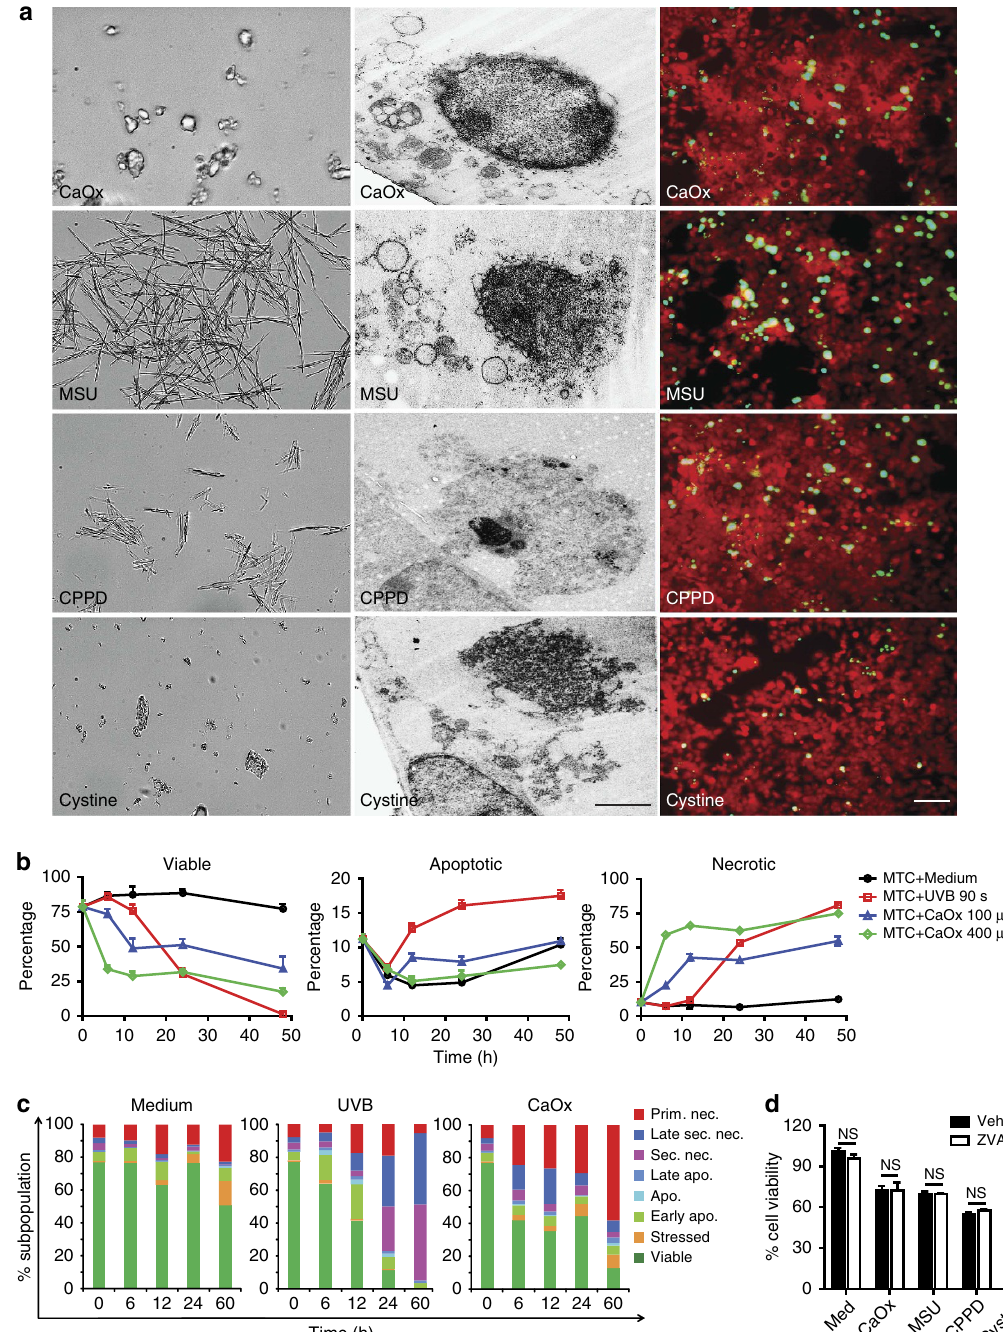
Figure 1 | Crystals induce primary cell necrosis. ( a ): Various crystals were incubated with tubular epithelial cells as indicated. Images show the crystal shapes at a magnification of (cid:2) 1,000 (left), TEM images shows that these crystals induce necrosis of tubular epithelial cells as indicated by ruptured plasma membranes (middle, (cid:2) 2,000), scale bar, 2 m m. The images on the right show the same rhodamine-labelled monolayers (red) 24h later. When Sytox green is added to the medium cells with permeable plasma membranes turn green indicating cell death ( (cid:2) 200), scale bar, 40 m m. ( b ) Flow cytometry was used to define the type and stage of tubular cell (MTC) death on CaOx crystal exposure or ultraviolet light type B for 90s (s) over a period of 50h as described in methods. Data for viable cells, apoptotic cells and necrotic cells are expressed as the percentage of viable cells ± s.e.m. of all cells for each time point. ( c ): The graphs show a quantitative analysis of the same experiment displaying all different phenotypes of tubular epithelial cells. Flow cytometry cell death definitions are described in the methods section. ( d ) Mouse tubular epithelial cell viability on crystal exposure by 3-(4,5- dimethylthiazol-2-yl)-2,5-diphenyltetrazolium bromide assay with and without the pan-caspase inhibitor ZVAD–FMK–FMK. All data are mean ± s.e.m. of at least three independent experiments. CaOx, MSU, CPPD, NS, not significant. * P o 0.05 versus medium control, *** P o 0.001 versus respective control. TEM, transmission electron